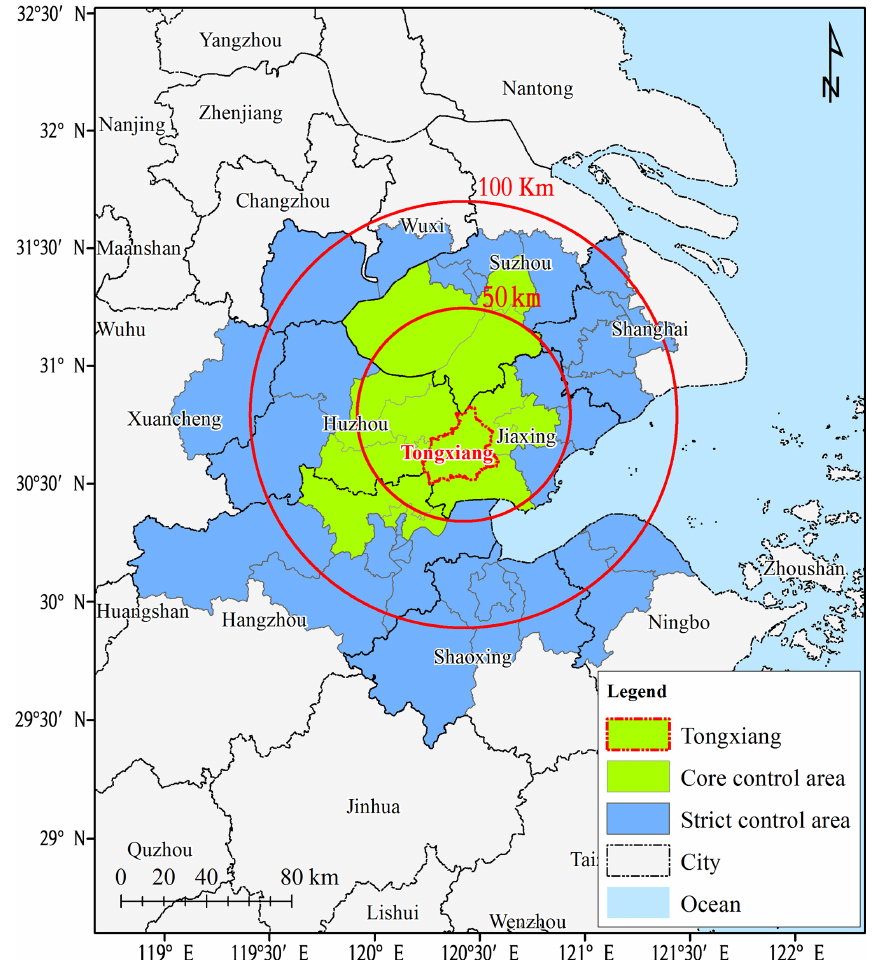
Figure 1. Controlled regions in the Action Plan for Air Quality Control during the World Internet